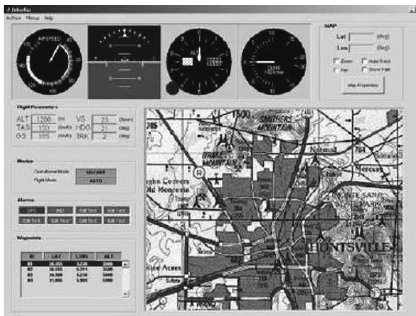
Figure 14: Ground Control Station GUI.